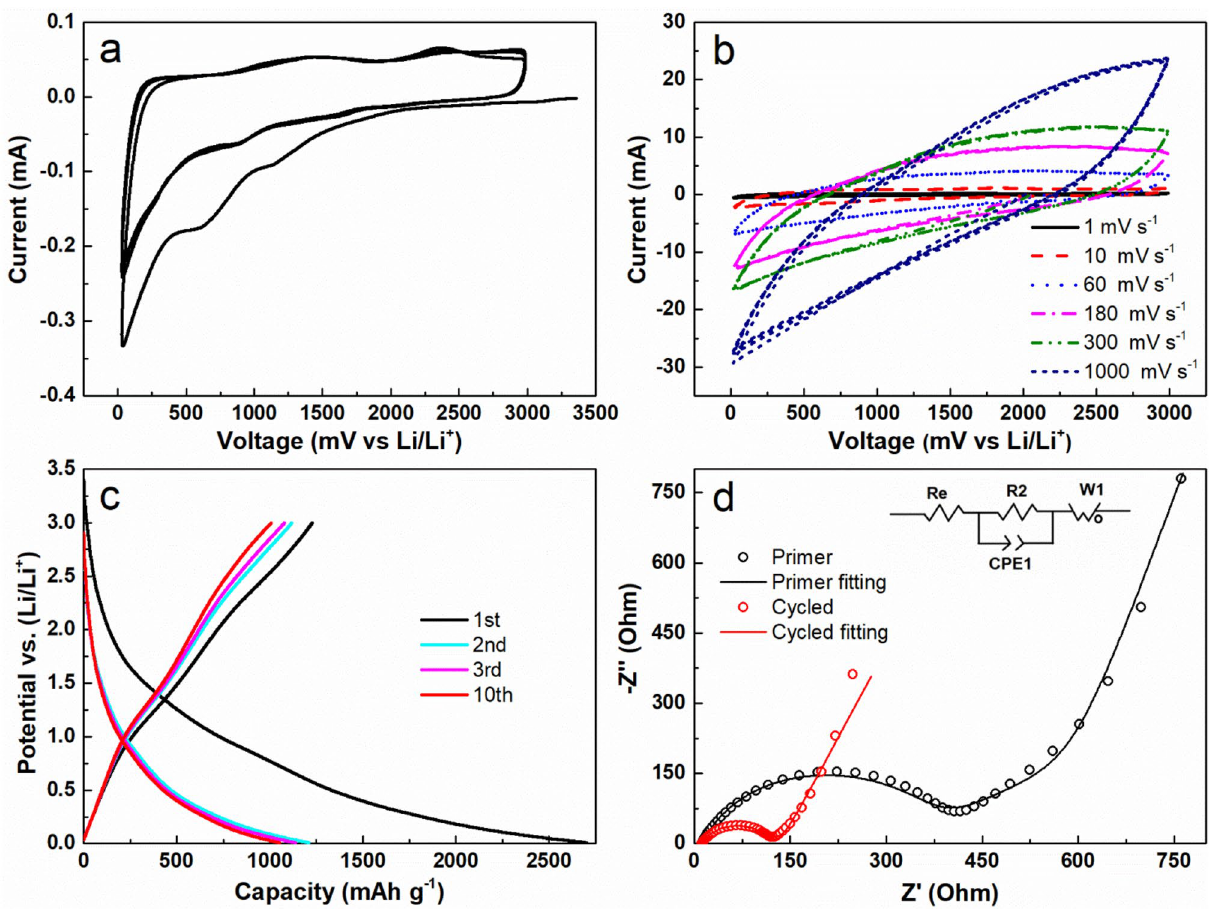
Figure 4. CV profiles of NBC@MWCNTs electrode in a potential range of 0.01 and 3 V: ( a ) at a scan rate of 0.2 mV s −1 of the initial three cycles; ( b ) at different scan rates from 1 to 1000 mV s −1 ; ( c ) Galvanostatic discharge/charge voltage profiles of different cycles at a current density of 0.1 A g −1 between 0.01 and 3 V for the NBC@MWCNTs electrode; ( d ) EIS of NBC@MWCNTs anode in a test window range from 100 kHz to 0.01 Hz before and after 10 electrochemical cycles for the cycling performance test at 0.1 A g −1 . The inset is the equivalent circuit model of the studied